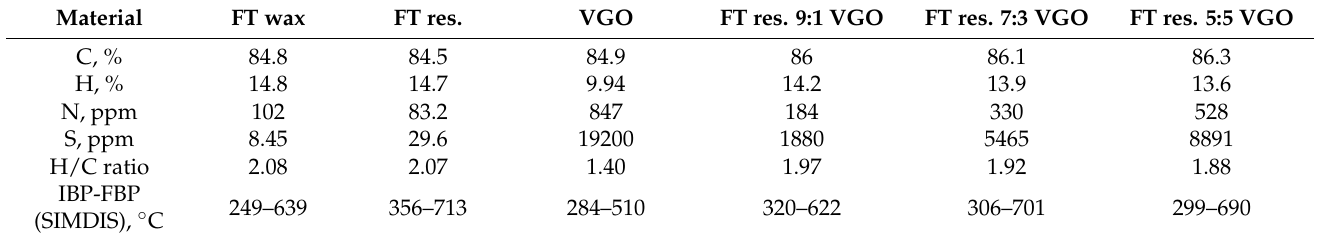
Table 5. Characteristics of the raw materials and feedstocks for the hydrocracking reaction.